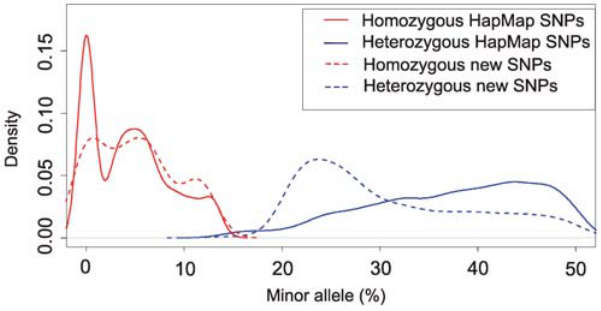
Figure 6. Distribution of percentages of a minor variant for SNPs as recovered by Illumina sequencing. Red: homozygous SNPs, blue: heterozygous SNPs. Solid line: HapMap SNPs, dashed line: new